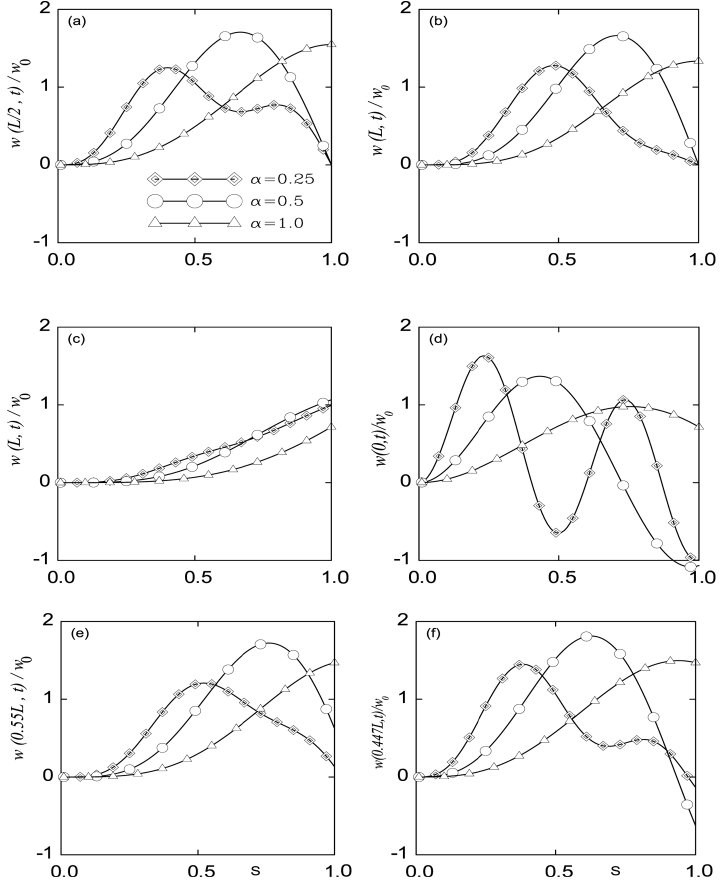
Fig. 1. Dynamic response ( w ( x max ,t ) /w 0 ) for various values of α and ζ n = 0 at x max for (a) hinged-hinged, (b) fi xed- fi xed, (c) fi xed-free, (d) free- fi xed, (e) fi xed-hinged, and (f) hinged- fi xed